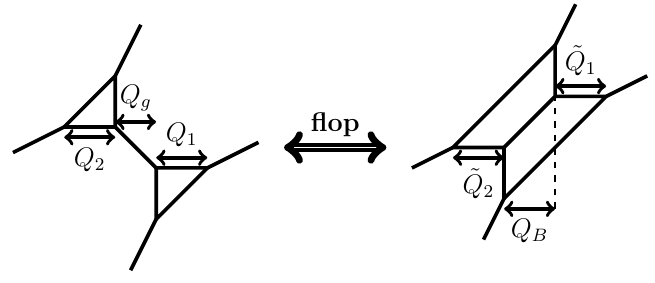
Figure 21 . A (cid:13)op transition for the gluing cuve in (cid:12)gur